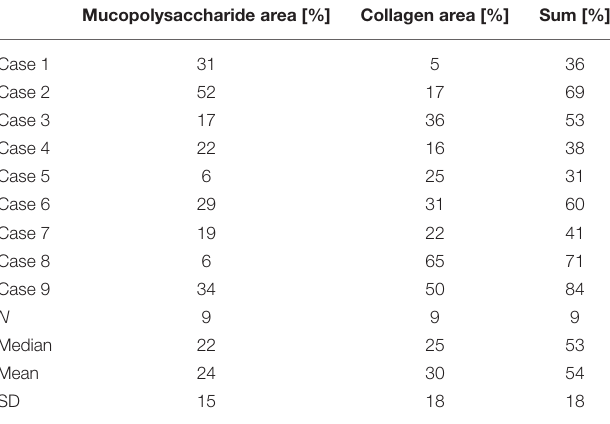
TABLE 6 | Histopathological measurements. TABLE 7 | Correlations between CMR and histopathological measurements of